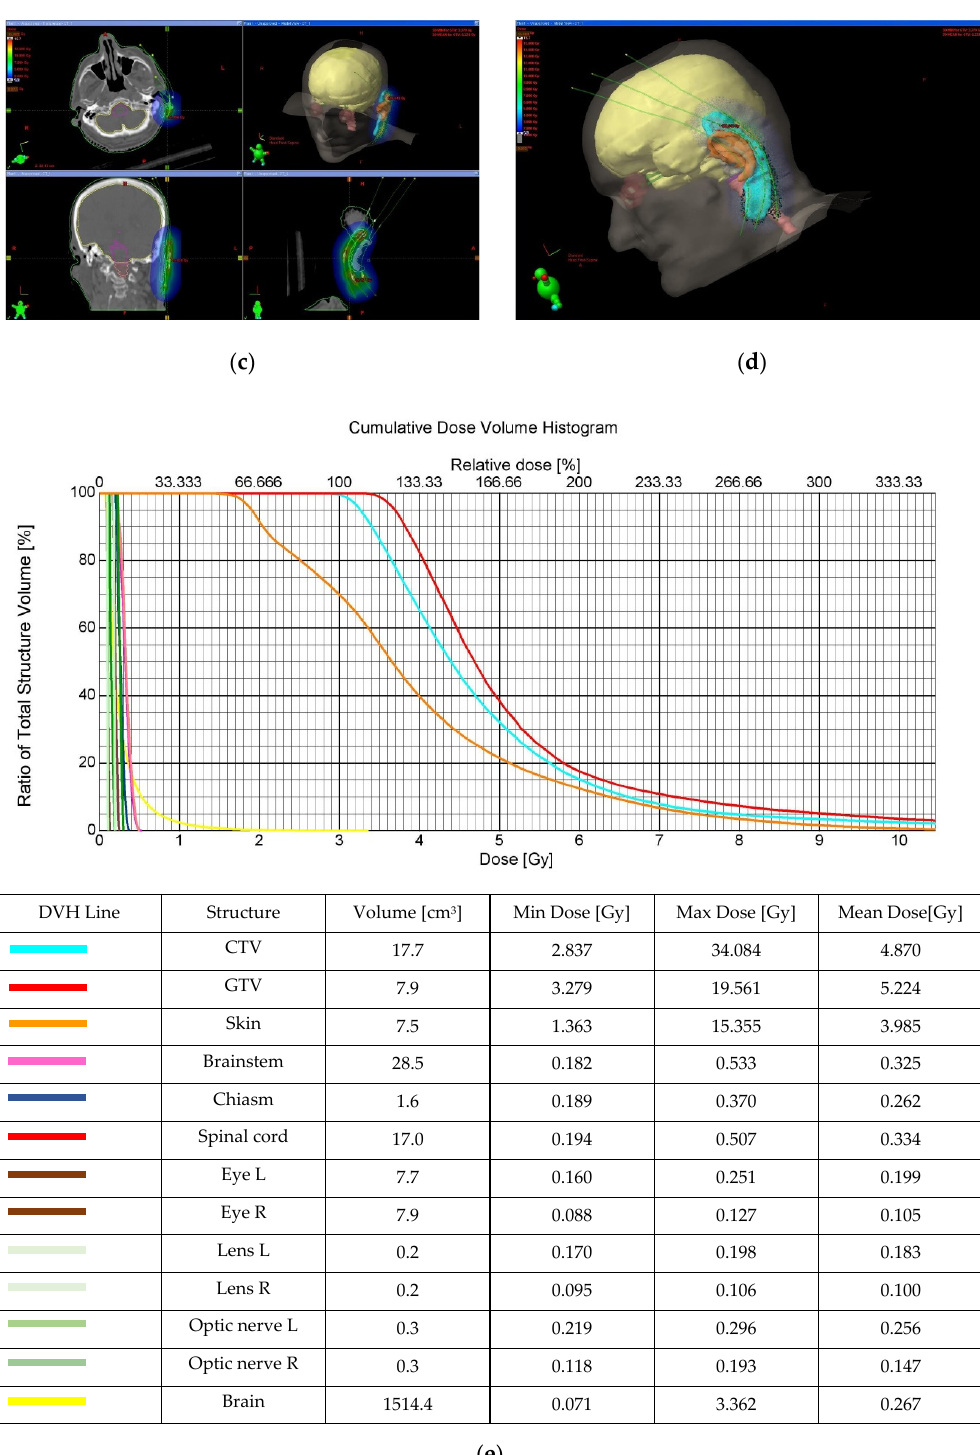
Figure 2. ( a ) Delineation of the brachytherapy target volumes and organs at risk for a patient with non-melanoma skin cancer around the ear, transverse plane; ( b ) Delineation of the brachytherapy target volumes and organs at risk for a patient with non-melanoma skin cancers around the ear, coronal plane; ( c ) The 2D and 3D dose distribution of brachytherapy application; ( d ) A 3D reconstruction of the clinical target volume and CTV surface applicators; ( e ) Dose-volume histogram for target volumes and